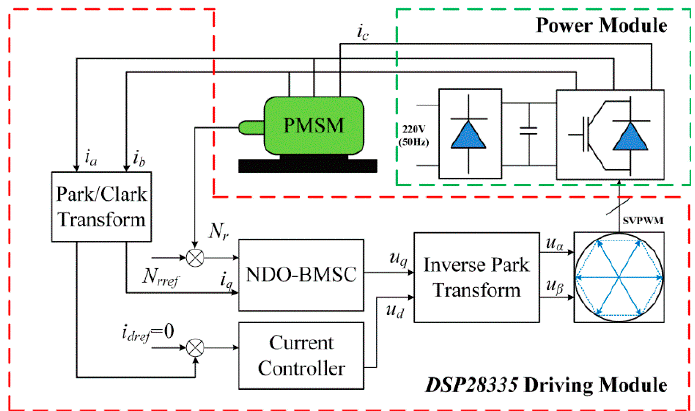
Figure 1. PMSM servo speed control system.